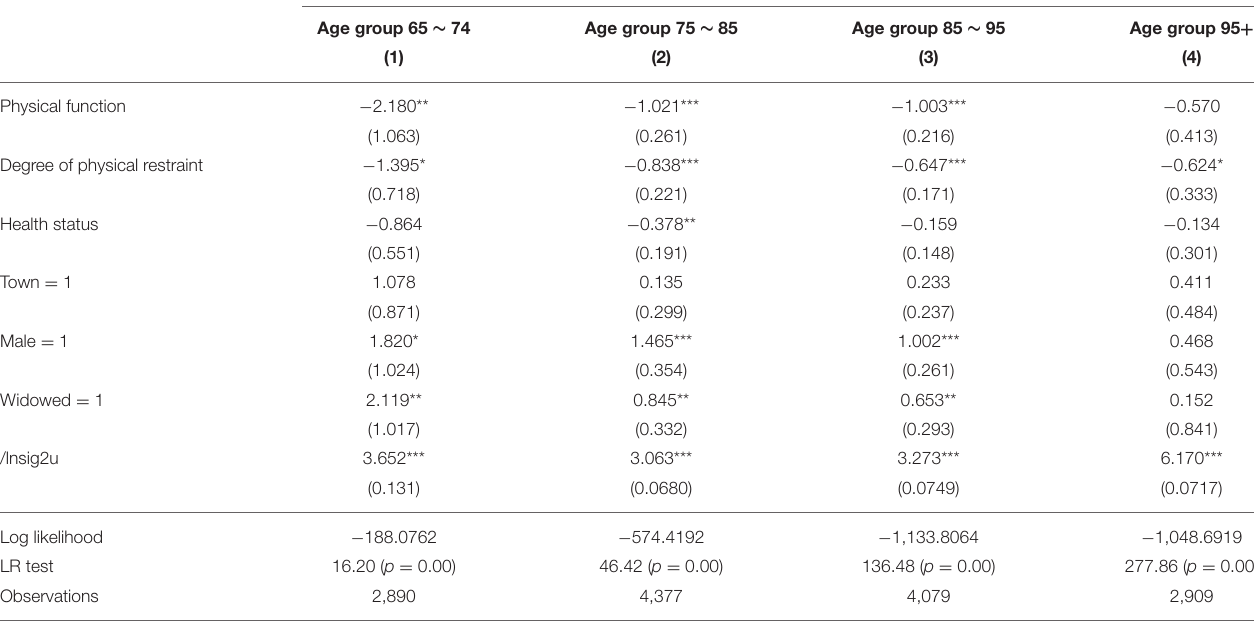
TABLE 2 | Logit death probability model.